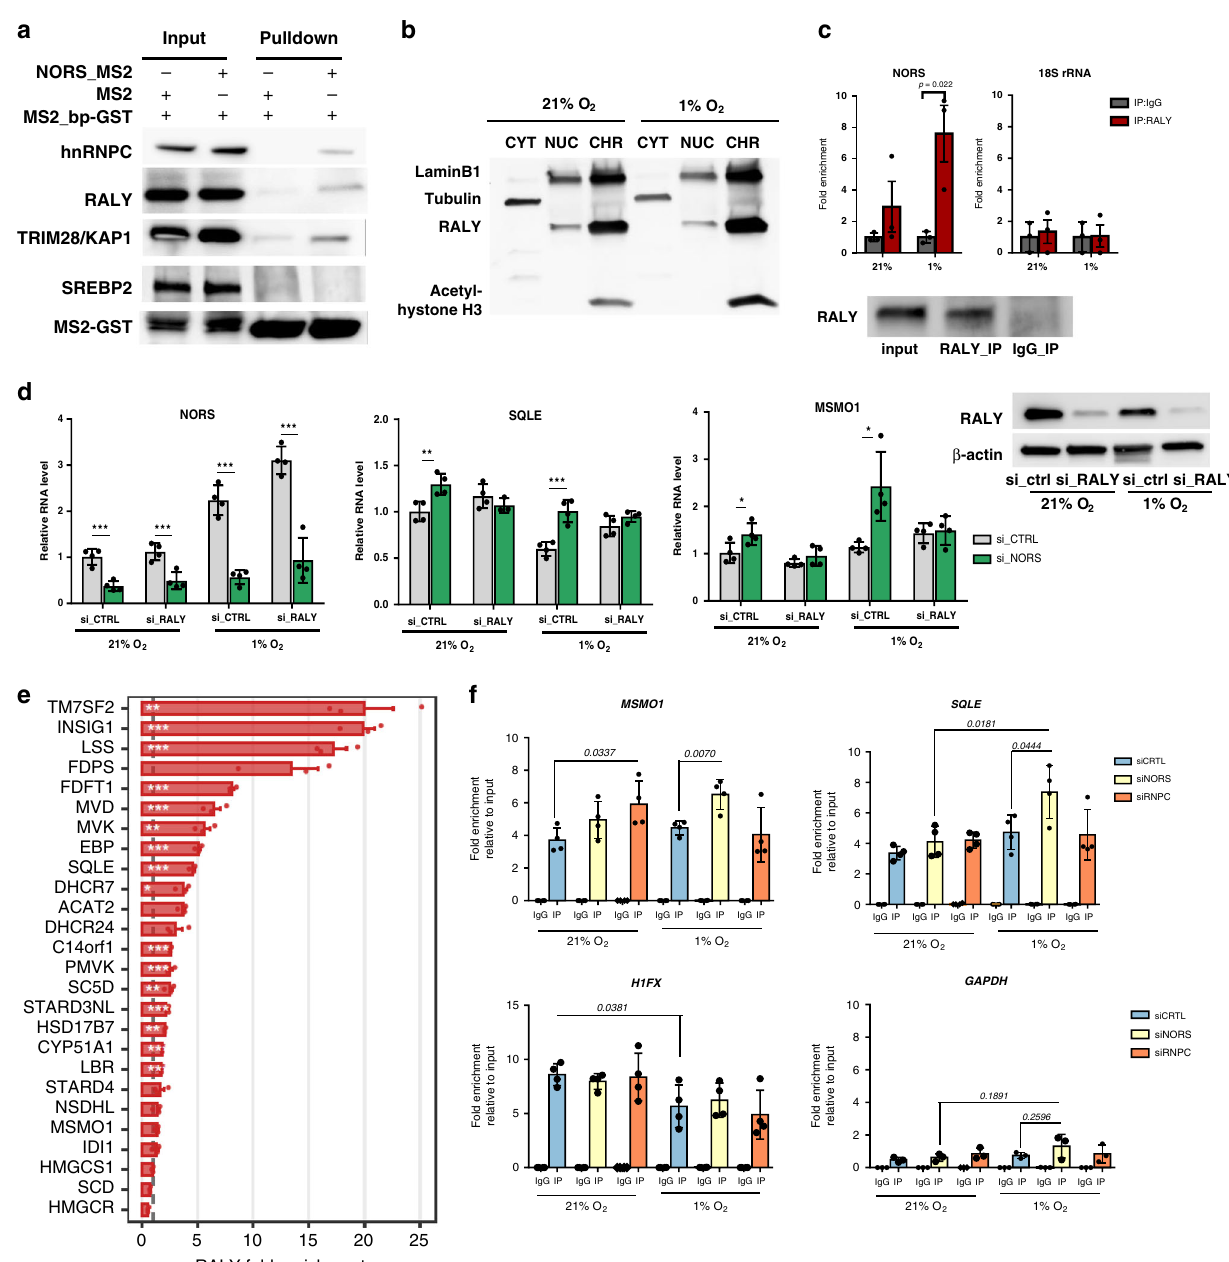
Fig. 6 lincNORS regulates cholesterol synthesis via interaction with RALY. a The level of hnRNPC, RALY, TRIM28, SREBP2, and MS2-GST in the MS2 pulldown material and input lysate was detected by western blot. The data presented are a representative image from two to three independent experiments. b Subcellular location of RALY was detected by western blot. Tubulin, Lamin-B1, and acetyl-histone H3 were included as controls for cytoplasmic, nuclear, and chromatin-associated fractions. A representative image from three independent experiments is shown. c RNA immunoprecipitation (RIP) analysis of RALY. The presence of lincNORS and 18s rRNA in the precipitated complex was detected by qPCR. Data represent mean ± SD from three biological replicates (two-sided Student ’ s t -test). d qPCR analysis of NORS, MSMO1 , and SQLE expression in MCF-7 cells transfected with control, lincNORS siRNA, and/or RALY siRNA. Data represent mean ± SD from four biological replicates (two-sided Student ’ s t -test). RALY knockdown was con fi rmed by western blot in each experiment and a representative image is shown on the right. e Enrichment of RNA of cholesterol synthesis genes in RALY-containing immunoprecipitated complex. The barplot displays the mean fold enrichment ± S.E.M. from three independent RALY RIP-Seq vs control experiments in MCF7 cells. The statistical signi fi cance of the enrichment was determined with CuffDiff v2.2.1 (*FDR < 0.05, **FDR < 0.01, ***FDR < 0.001). Source data are provided as a Source Data fi le. f Enrichment of MSMO1, SQLE, H1FX, and GAPDH in RALY-containing immunoprecipitated complex after lincNORS or hnRNPC knockdown was detected by qPCR. Data represent mean ± SD from four biological replicates (two-sided Student ’ s t